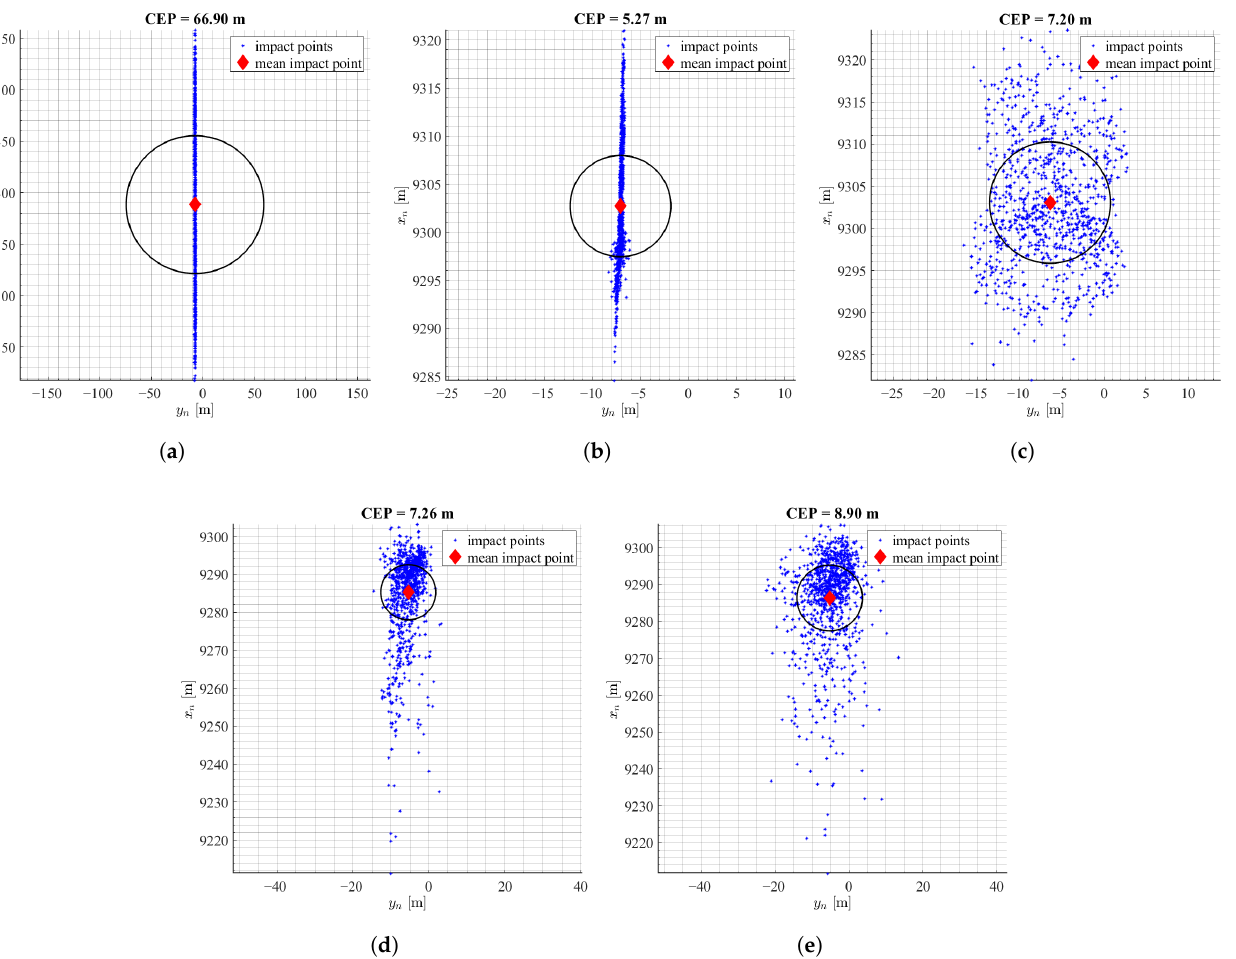
Figure 8. Results of landing point dispersion with uncertainties of thrust data: ( a ) no